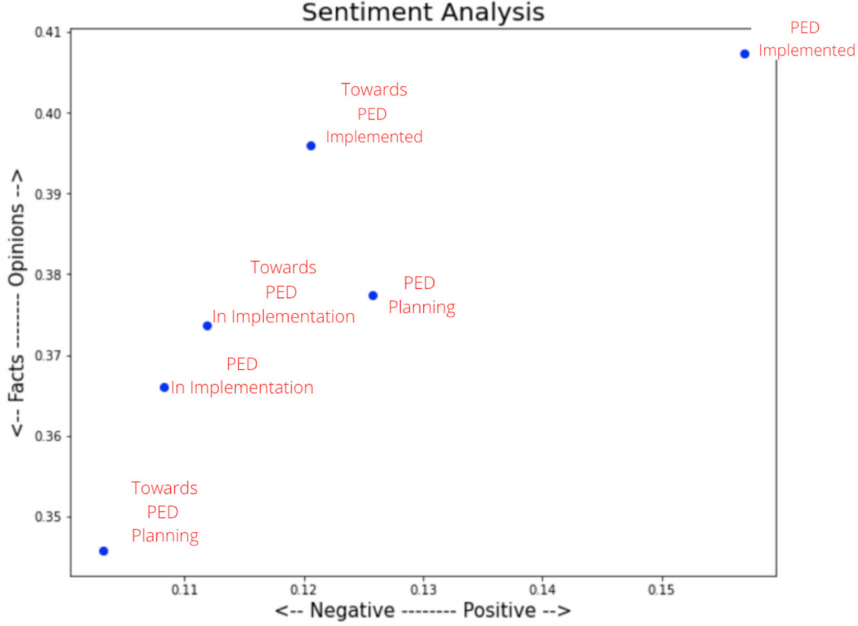
Figure 10. Sentiment